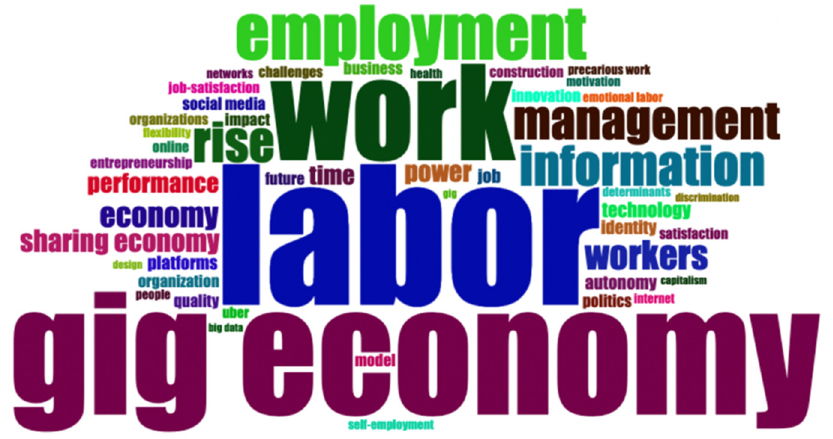
Figure 6. Word map of keywords. Source: RStudio results.